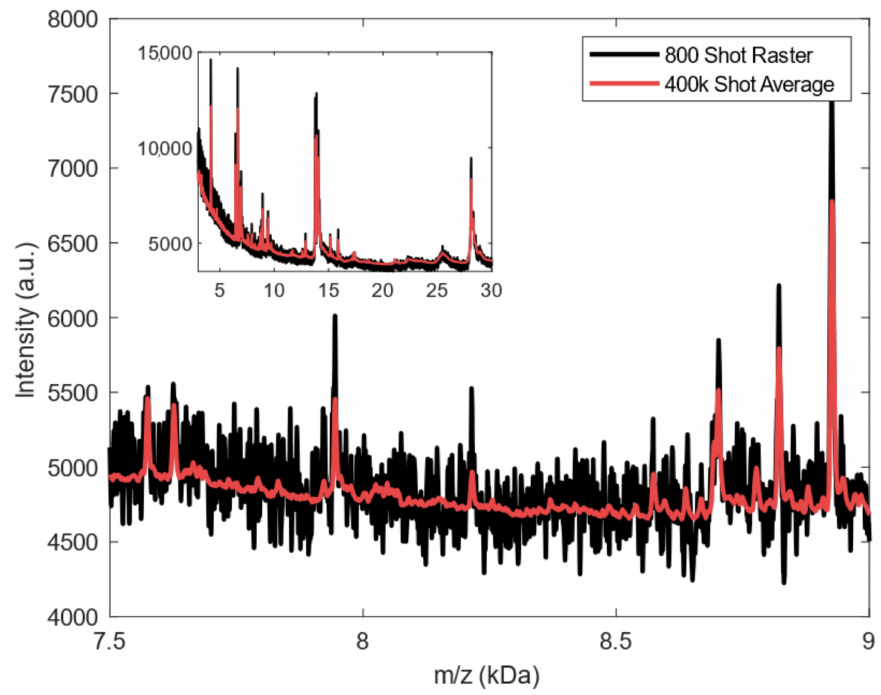
Figure 1. Example spectra collected on the RapifleX of an individual raster spectrum (black) and a 400,000 shot Deep MALDI averaged spectrum (red) from 7.5 to 9 kDa m/z range. The inset shows the same spectra over the full 3 to 30 kDa range analyzed in this work.